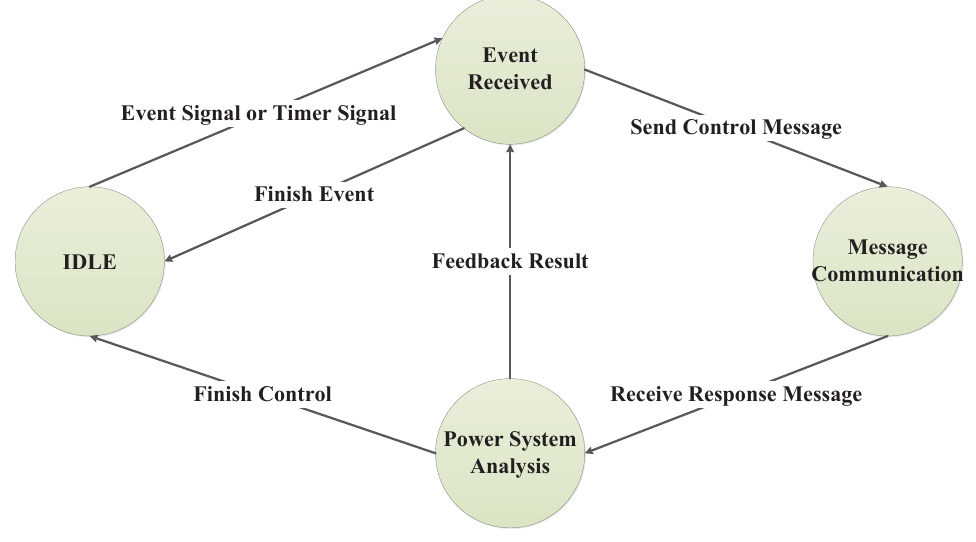
Figure 2. The finite state machine of the